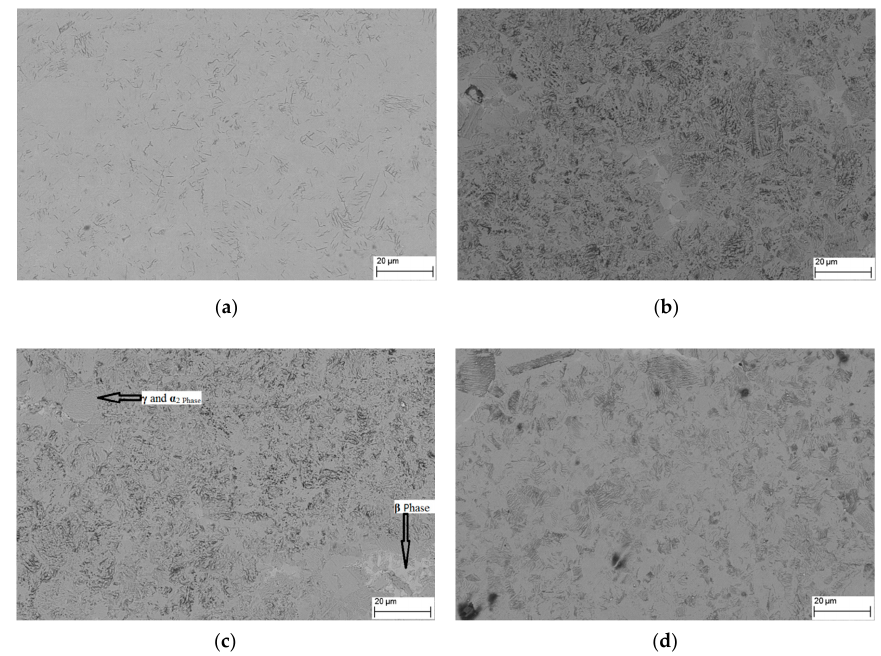
Figure 4. SEM images of ( a ) Ti-48Al-2Cr-2Nb + 0% Mn, ( b ) Ti-48Al-2Cr-2Nb + 2.5% Mn, ( c ) Ti-48Al-2Cr-2Nb + 5% Mn, and ( d ) Ti-48Al-2Cr-2Nb + 7.5% Mn.